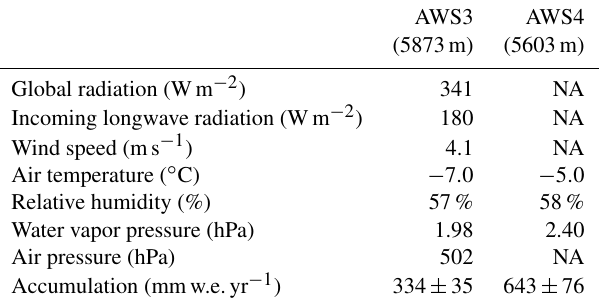
Table 1. Measured mean values at AWS3 and AWS4 between 8 Oc- tober 2009 and 30 September 2013. The unmeasured variables at AWS4 are denoted